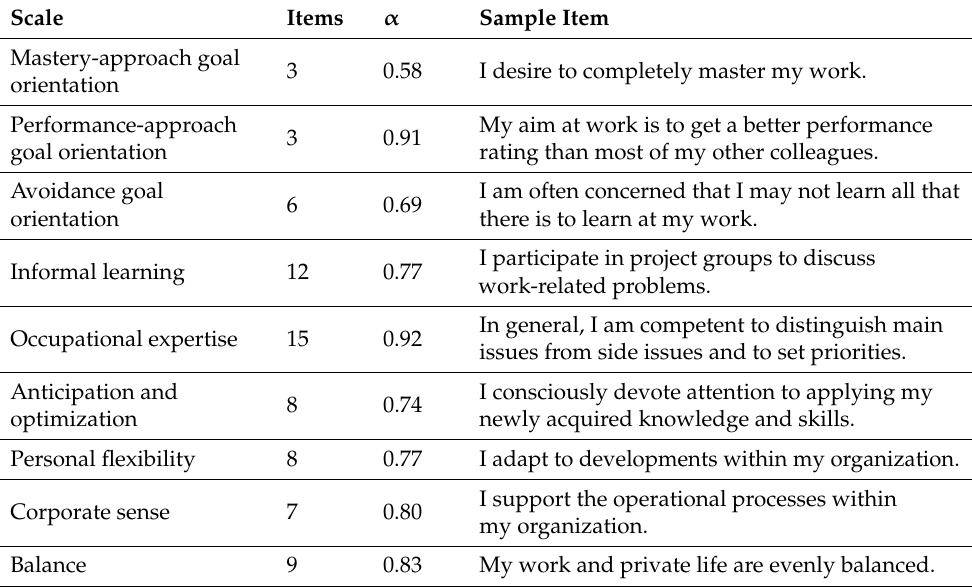
Table 1. Description and internal reliability of the